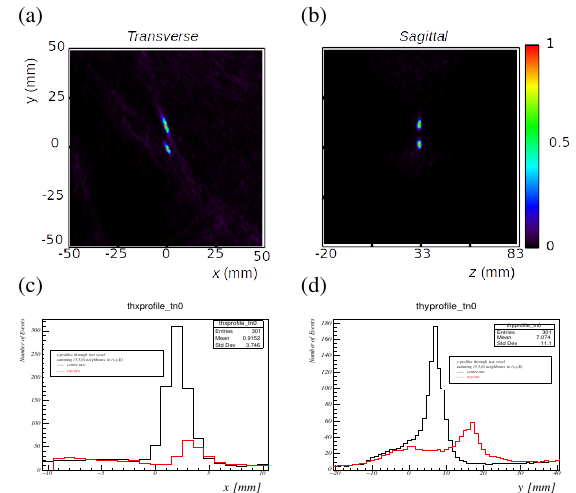
Fig. 7: Reconstructed 22 Na point-like source position (trans- verse (a) and sagittal (b) planes) in the centre of the scanner and 10 mm above. Profiles of the reconstructed data through the x-axis (c) and y-axis